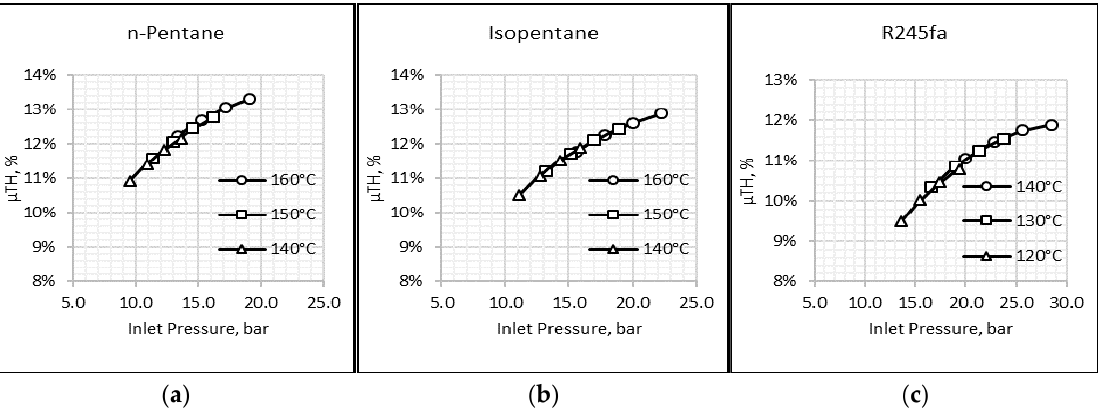
Figure4. Thermale ffi ciencyoptimizationresultswithvariedtemperatureandpressurefor( a )n-Pentane; Figure 4. Thermal efficiency optimization results with varied temperature and pressure for ( a ) n- ( b ) Isopentane; ( c ) Pentane; ( b ) Isopentane; ( c ) R245fa.